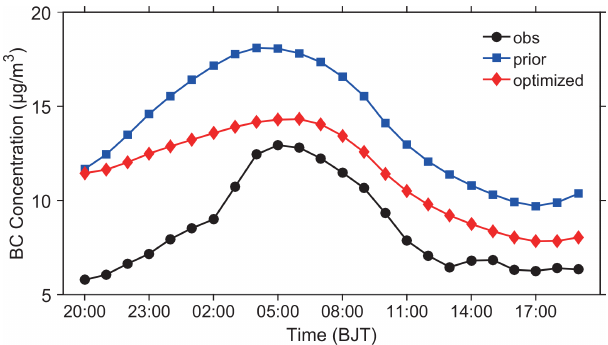
Figure 7. Comparison of observed and simulated (with the prior and optimized BC emissions, respectively) BC concentrations in Beijing from 20:00, 3 July, to 19:00, 4 July 2016. The observed BC concentrations were calculated by the BC / PM 2 . 5 ratio